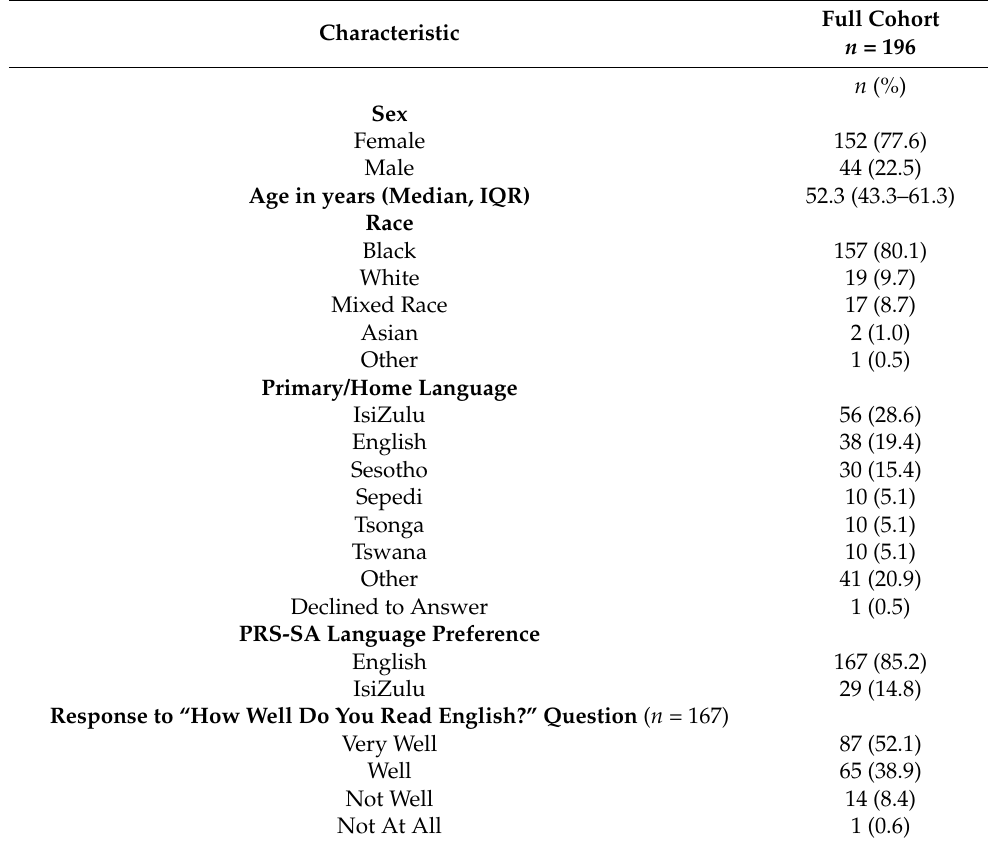
Table 1. Patient demographics and clinical characteristics. (Abbreviations: COPD-Chronic obstructive pulmonary disease, IQR-Interquartile range, PRS-SA-Patient Reported Symptoms-South Africa).